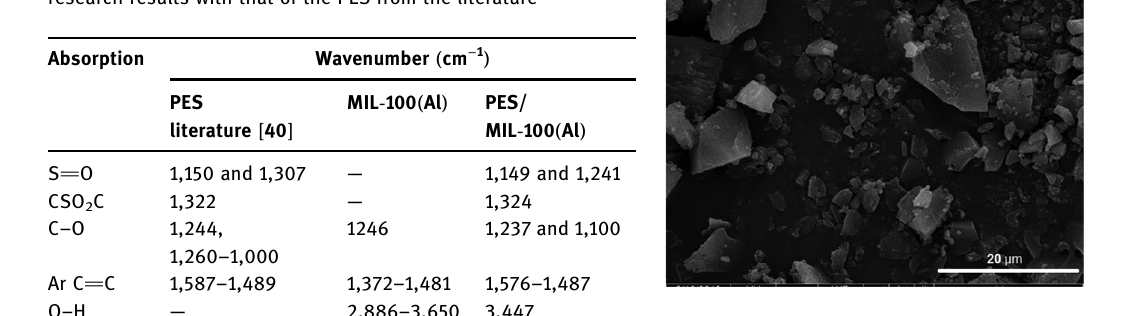
Figure 5: Depiction of the synthesized MIL - 100 ( Al )